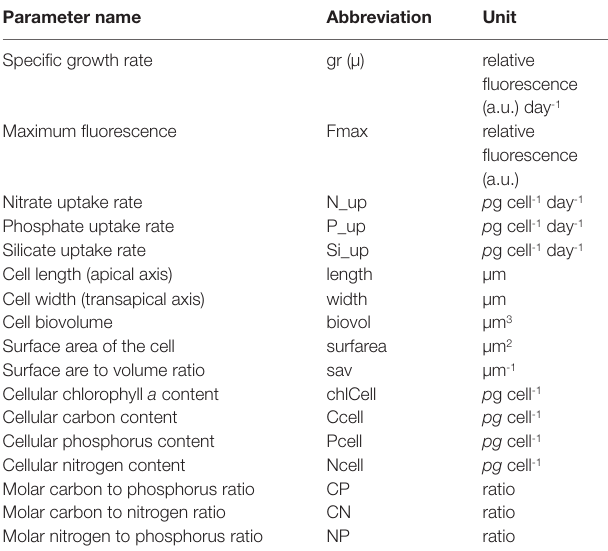
TABLE 1 | Phytoplankton traits estimated in five strains of A. ostenfeldii and S. marinoi